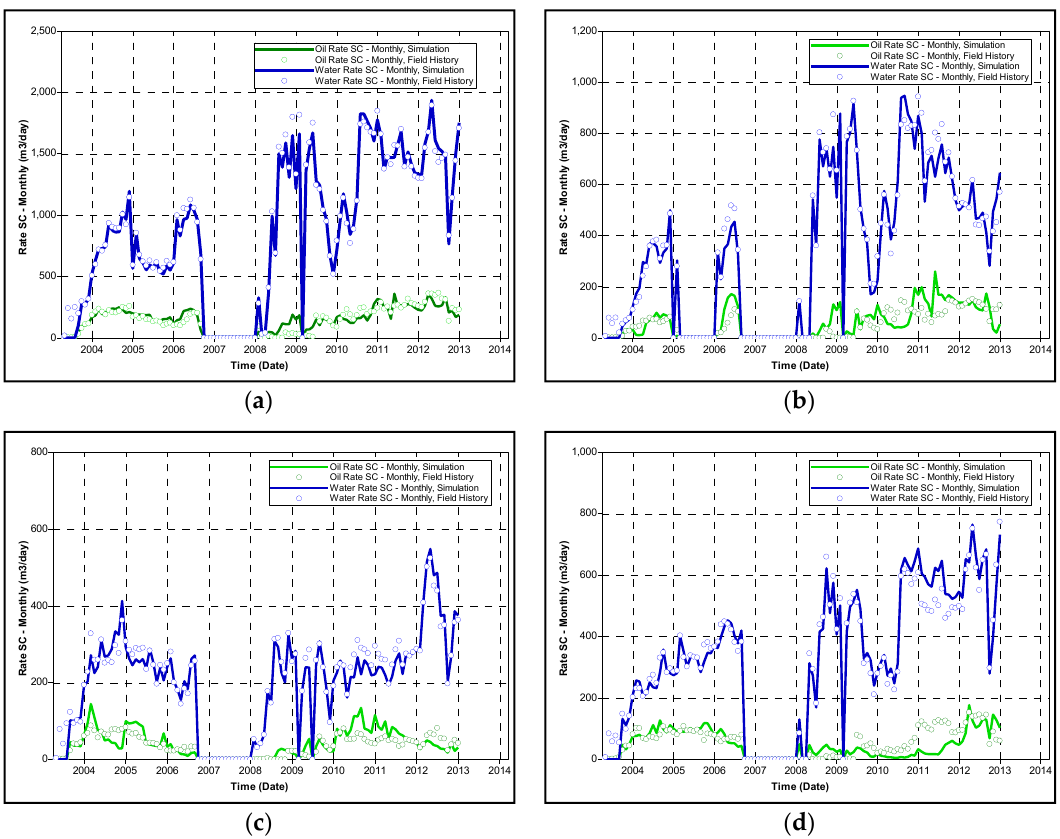
Figure 12. History match of oil and water production rate (( a ) the whole pad; ( b ) well pair 1; ( c ) well pair 2; ( d ) well pair 3).